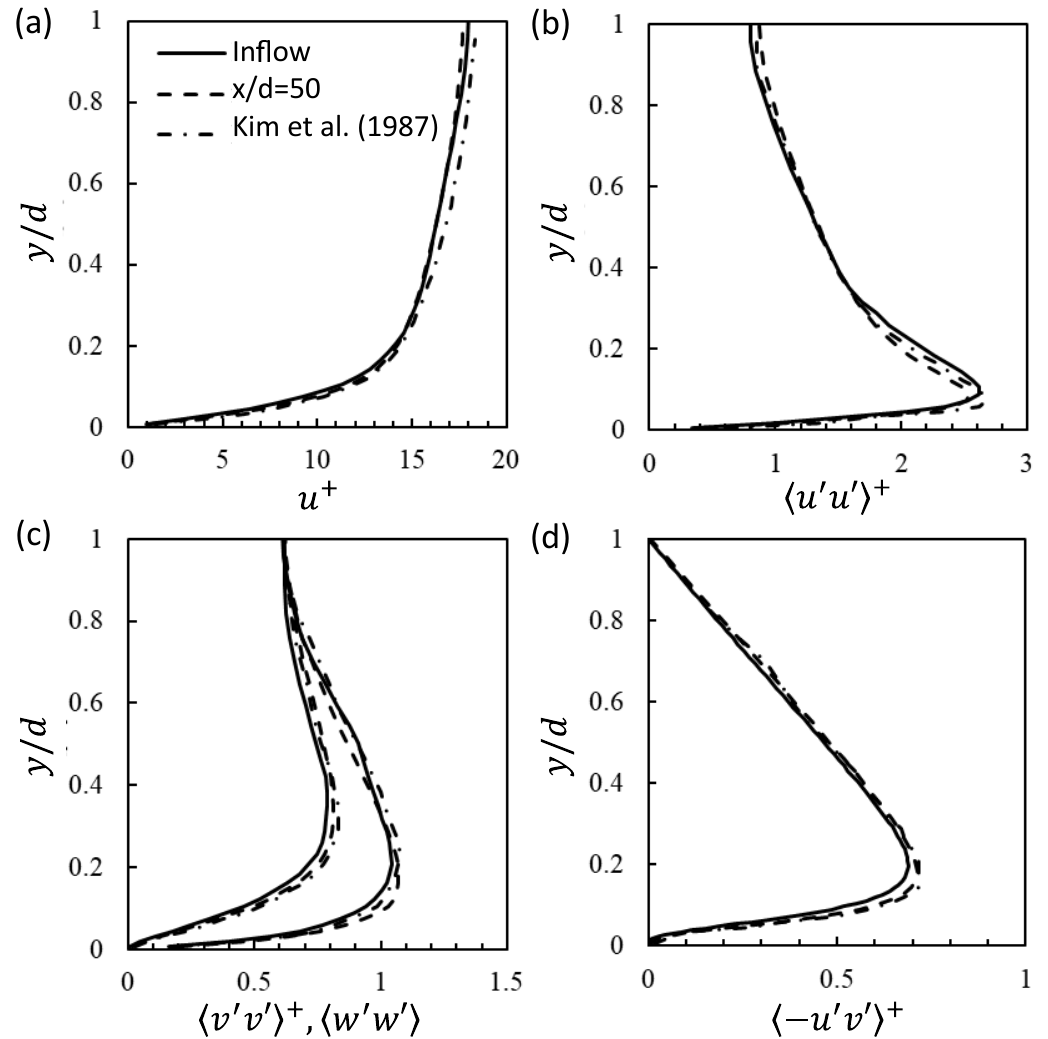
Figure 6. Mean and turbulent statistics in channel flow at the inlet, x / d = 50, and comparison with the study of Kim et al. [42]. ( a ) mean velocity profiles ( b ) streamwise stress profiles ( c ) vertical and transverse stress profiles ( d ) Reynolds stress